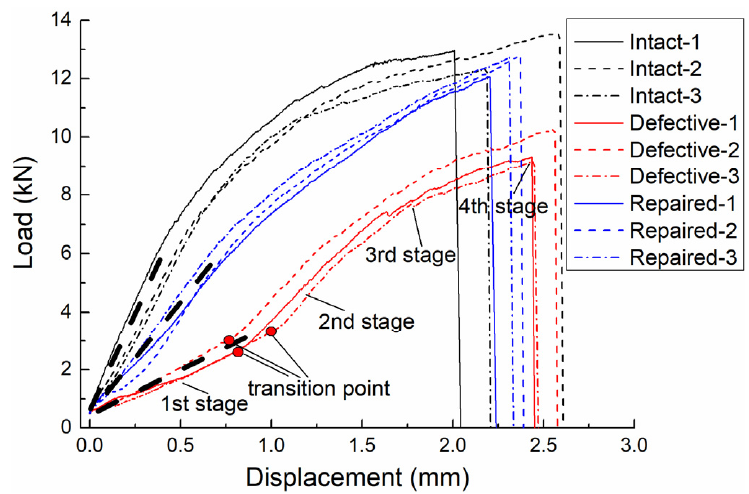
Figure 6. Load-displacement curves of intact, defective and repaired samples.